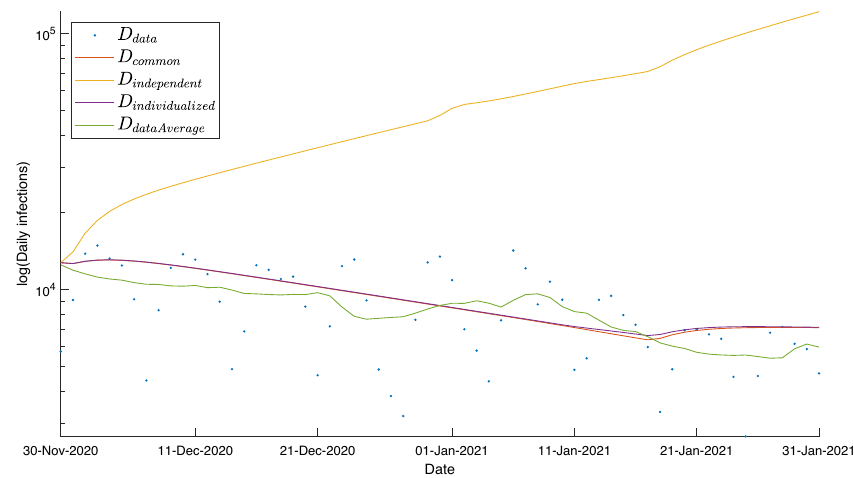
(a) Estimation results for Poland. Top panel: fitting a function of restrictions to the signal β opt . Bottom panel: Ability of the model to predict daily infections. The black vertical line indicates the beginning of the validation period. As the number of daily infections is highly variable, a seven day moving average is also presented